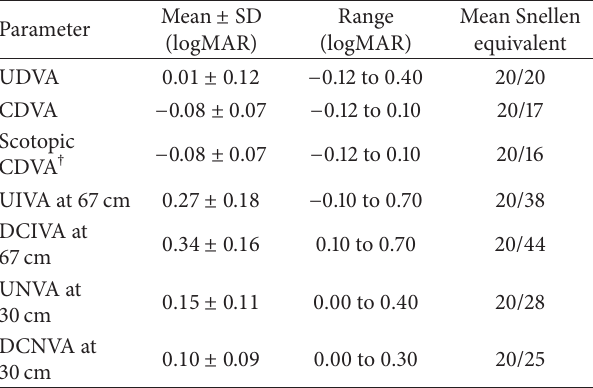
Table 1: Monocular visual outcomes at 6 months.